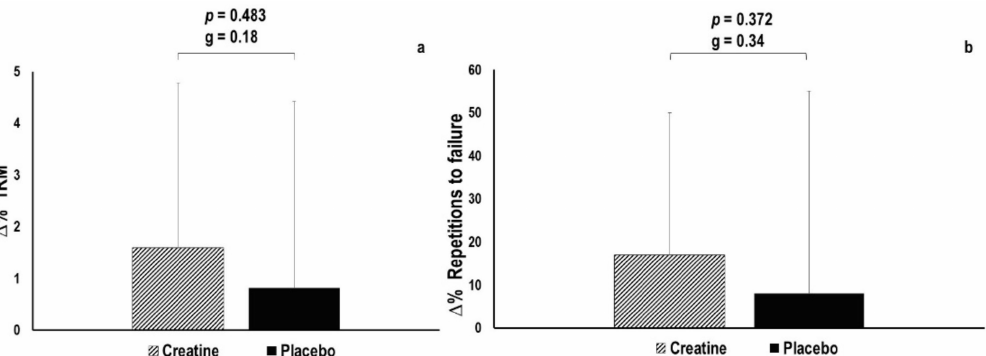
Figure 2. ( a ) Changes in maximal strength (one repetition maximum, 1RM) after a 7-day ingestion of creatine or placebo supplement. ( b ) Changes in number of repetitions performed in the repetitions-to-failure test (RFT) test after a 7-day loading of creatine or